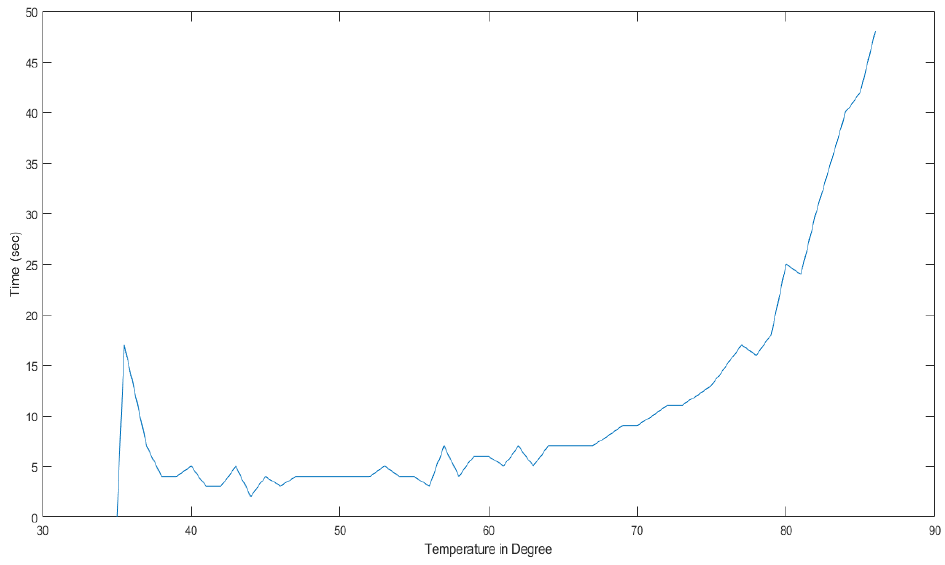
Figure 4. Step response of open-loop experimental data Figure 4 . Step response of open-loop experimental data [2] .